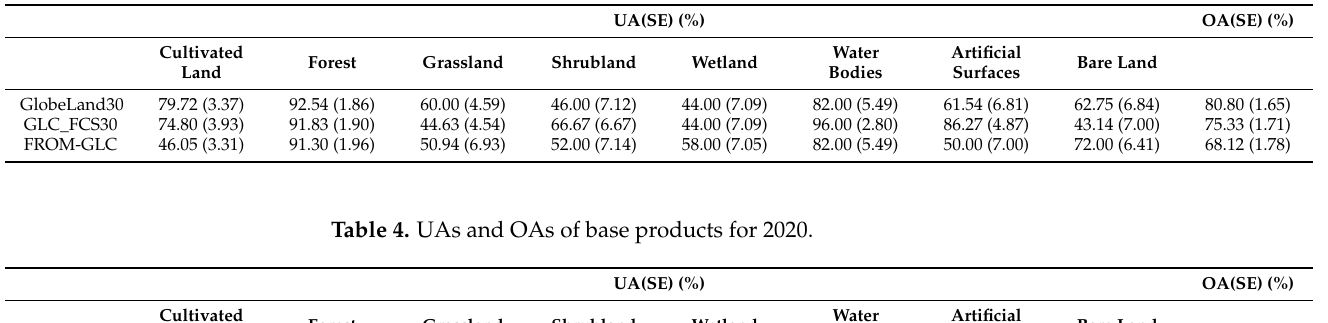
Table 3. UAs and OAs of base products for 2010.